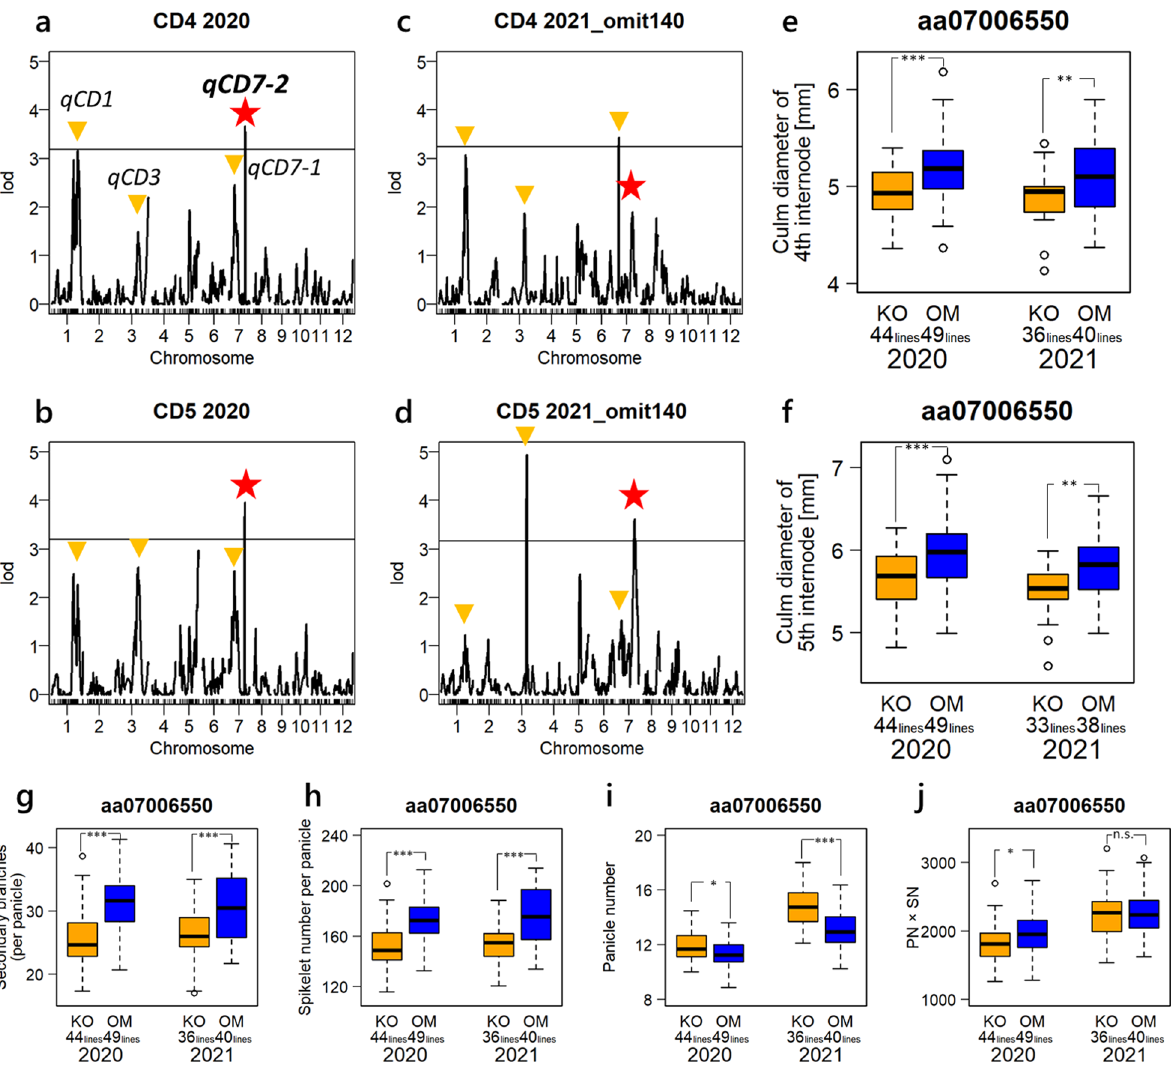
Fig. 3 QTL analysis of culm diameter and trait values by alleles in qCD7-2 . a , d : Result of QTL analysis of culm diameter: a 4th internode in 2020, b 5th internode in 2020, c 4th internode in 2021, d 5th internode in 2021. All 96 RILs were used for the QTL analysis in 2020 but the QTL analysis in 2021 was performed on 79 lines, excluding 17 lines with DTH exceeding 140 days. A peak marked with a red star is a major QTL, qCD7-2 . Other peaks marked with orange triangles are suggestive QTLs. e – j Trait values by alleles in qCD7-2 It is classified by genotype in “aa07006550”, which is a representative SNP marker for qCD7-2 . Asterisks indicate significant difference between both alleles: ***, **, *, and n.s. indicates p < 0.001, < 0.01, < 0.05, and 0.05, respectively ≥